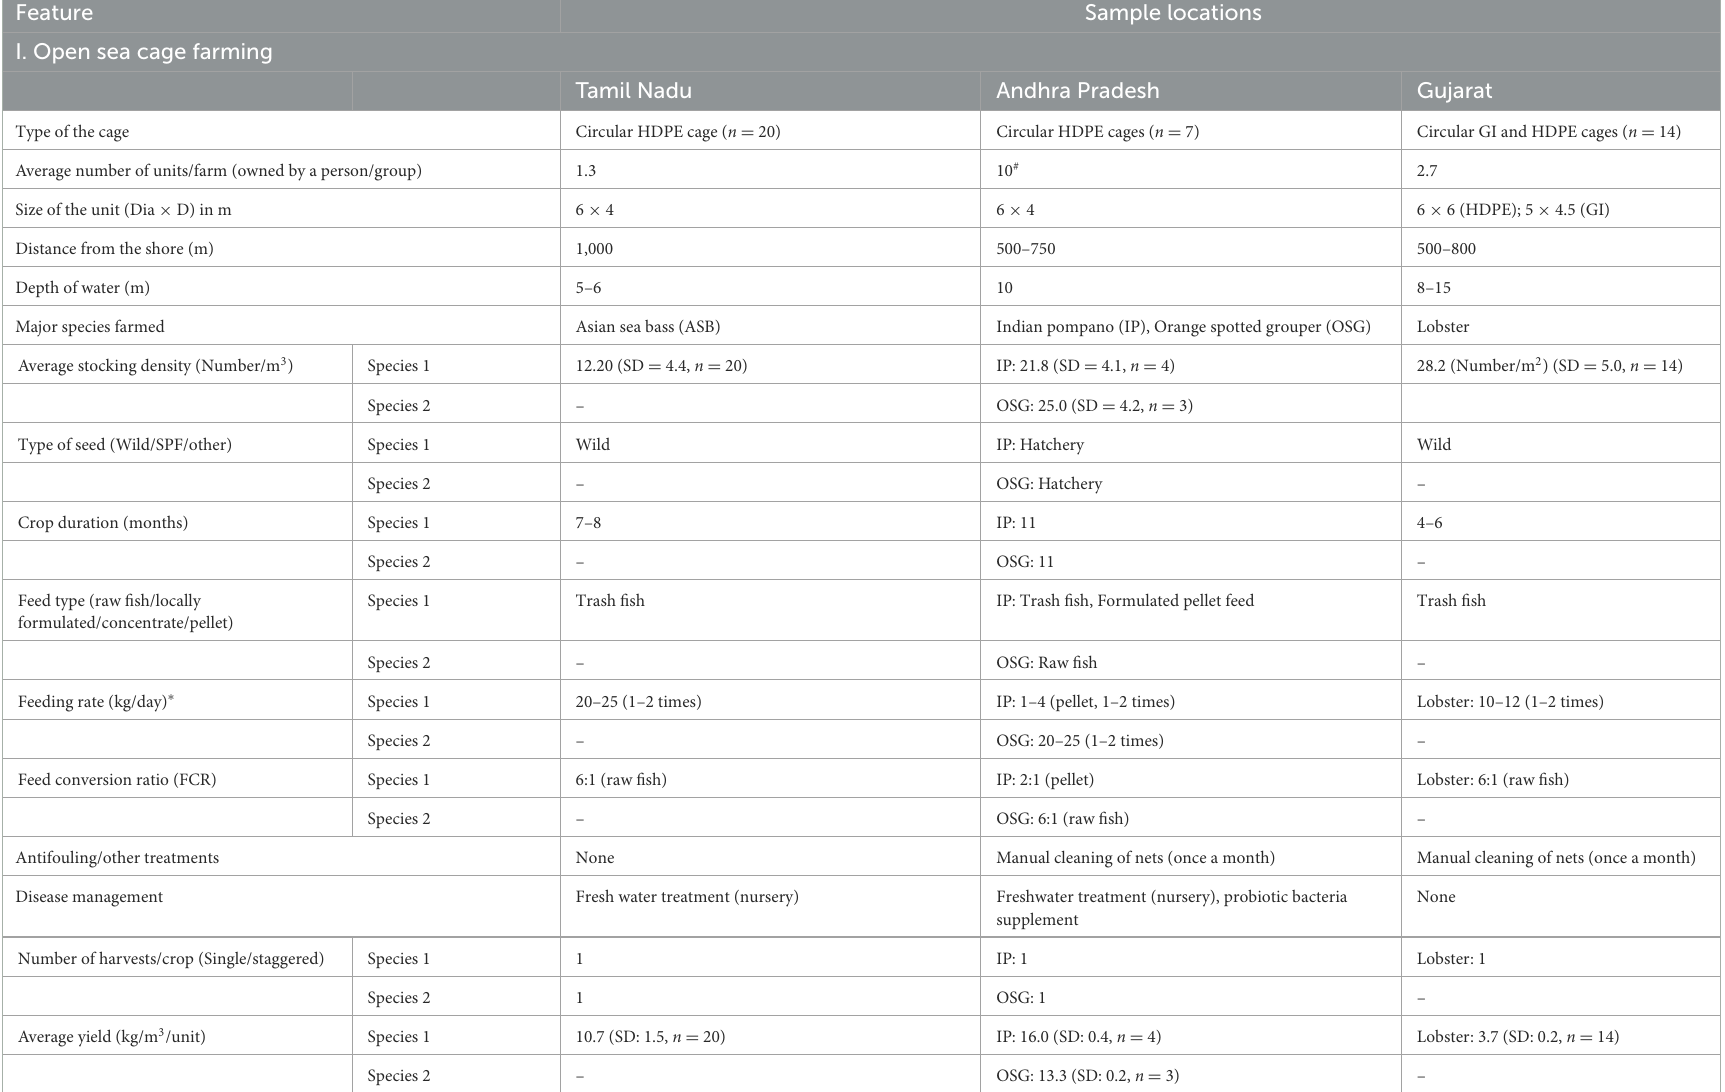
TABLE 3 General features of sample farms practicing mariculture in the selected coastal regions of